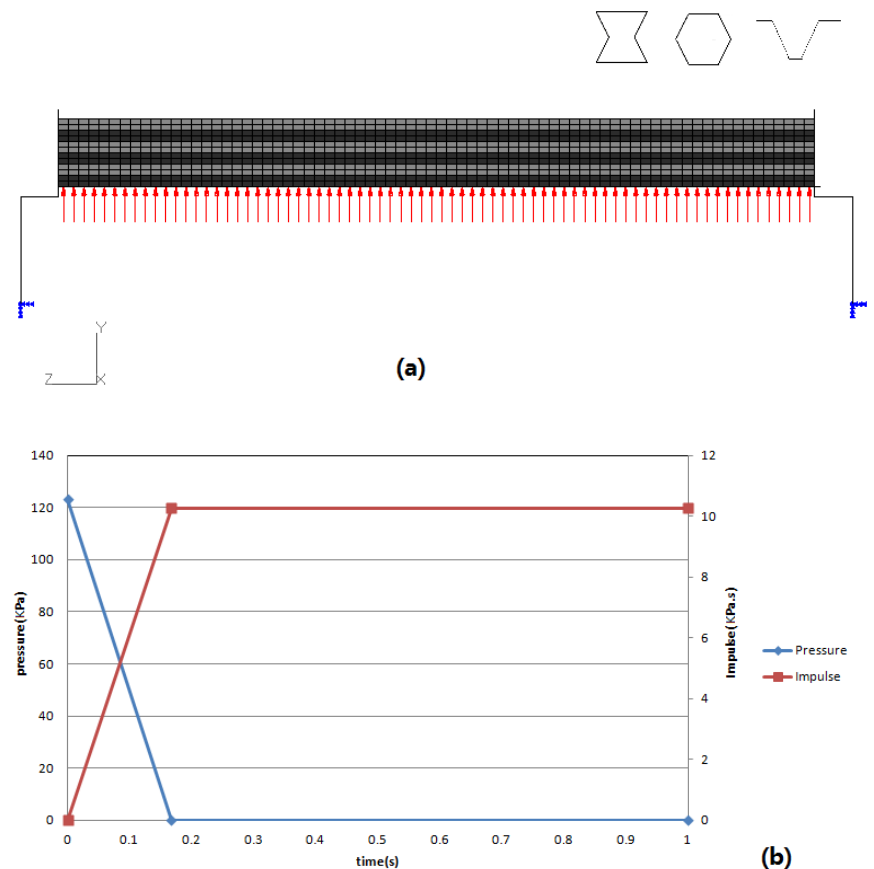
Figure 7. Distributed impulse loading and constraints. ( a ) The distributed impulse loading and constraints. ( b ) The pressure and impulse applied on the models.